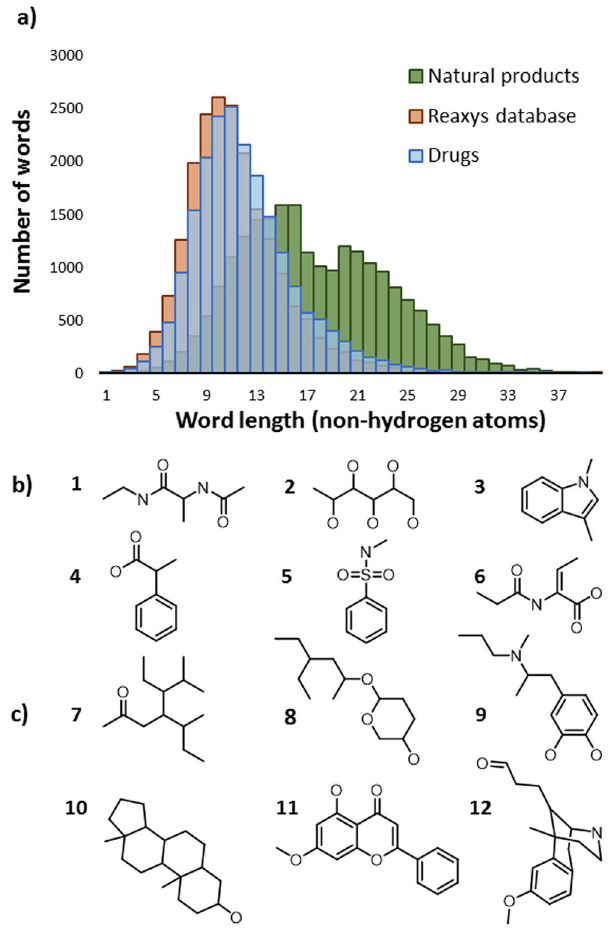
Figure 5. Distributions of MCS chemical word lengths and examples of such words. ( a ) Distribution of word lengths, measured by the number of non-hydrogen atoms, for molecules randomly chosen from Reaxys (orange), for drugs (blue), and for natural products (green). ( b ) Examples of words from the distribution of ( b ) drugs and ( c ) natural products. As in Fig. 1, the structures shown are molecular fragments not actual molecules with correct valences (e.g., if oxygen is monovalent, it can be attached to H, alkyl, aryl,